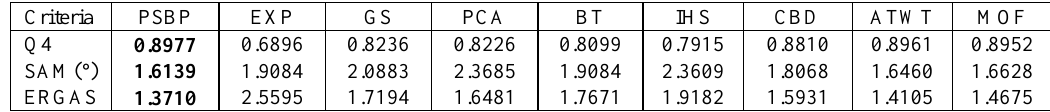
Table 2. Comparison results of the proposed PSBP method with other methods for Boulder dataset